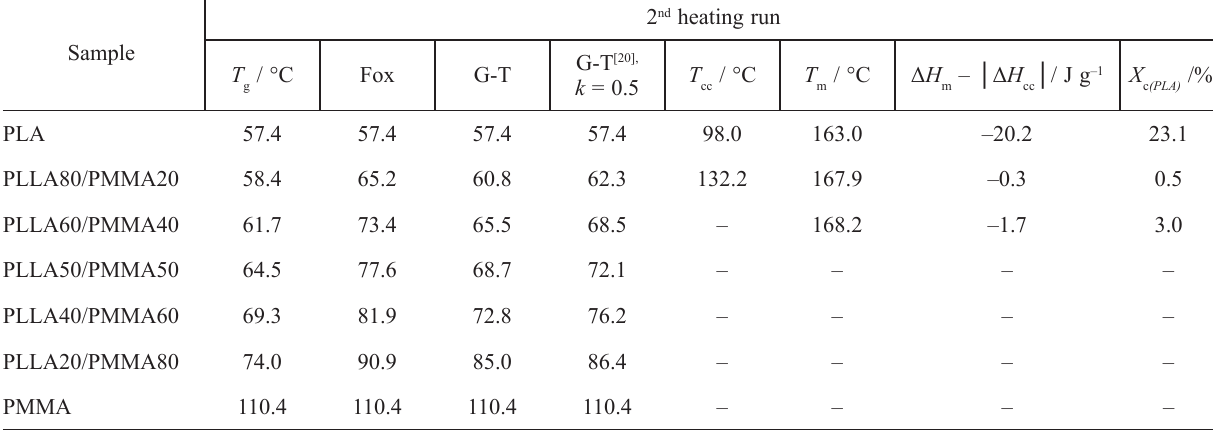
Table 3 – Thermal properties of neat poly(L-lactic acid) – PLLA, poly(methyl methacrylate) –PMMA, and their blends prepared by melt